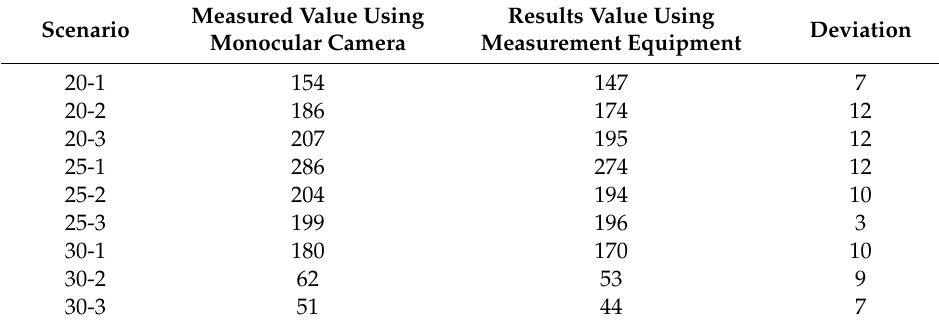
Table 11. Error factor by scenario of measured value using monocular camera vs results value using measurement equipment (CPNC),